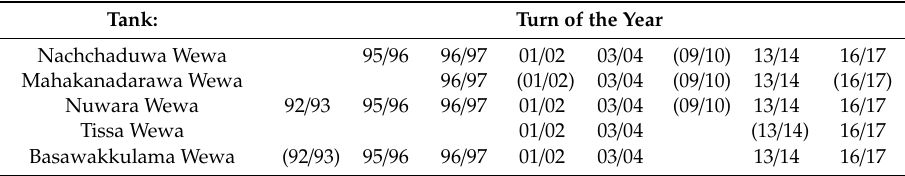
Table 4. Missing and weakly developed annual maximum water levels at the turn of the years for the five major tanks in the Aruvi Aru drainage basin (missing peaks = without brackets, weakly developed peaks = in